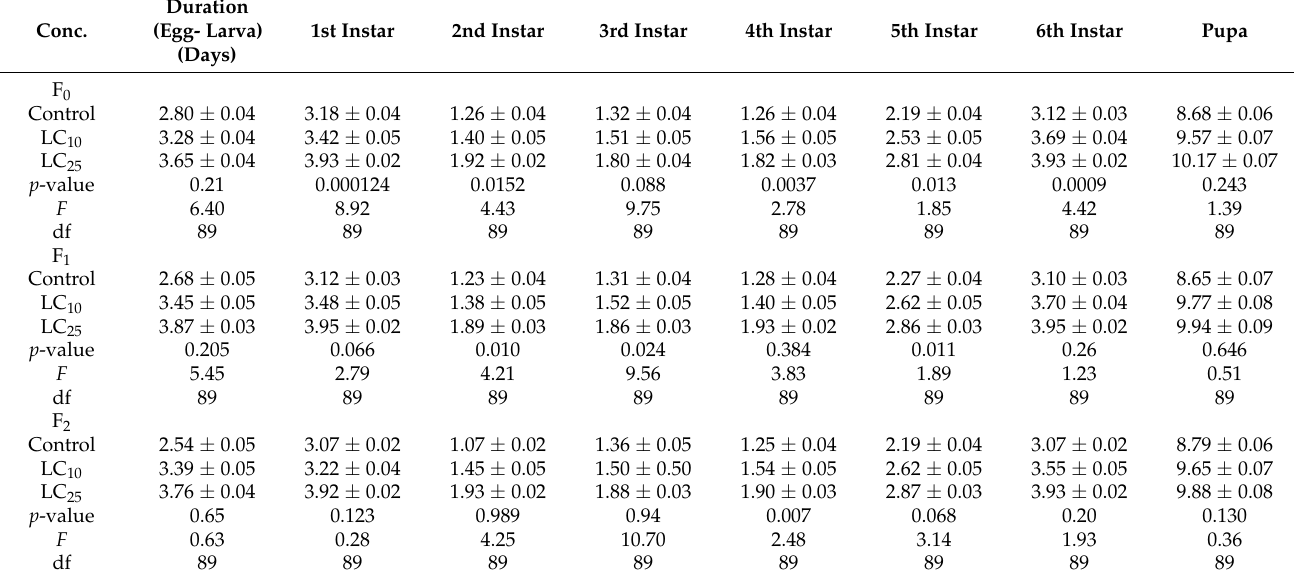
Table 2. Sub-lethal (LC 10 , LC 25 ) effects of chlorantraniliprole on biological traits of Spodoptera frugiperda for three generations.